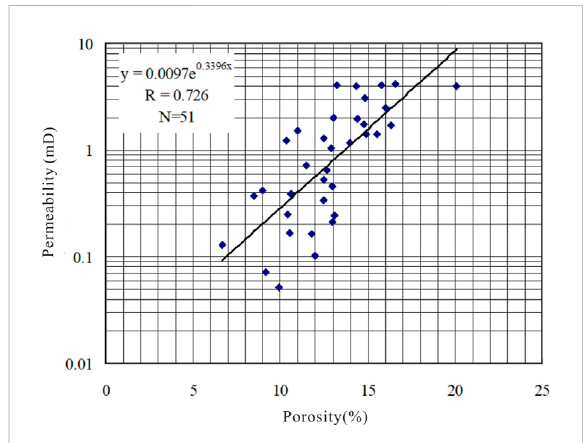
FIGURE 6 Relationship betweenporosityandpermeabilityofsandstone in the Chang 1 Member of the study area.